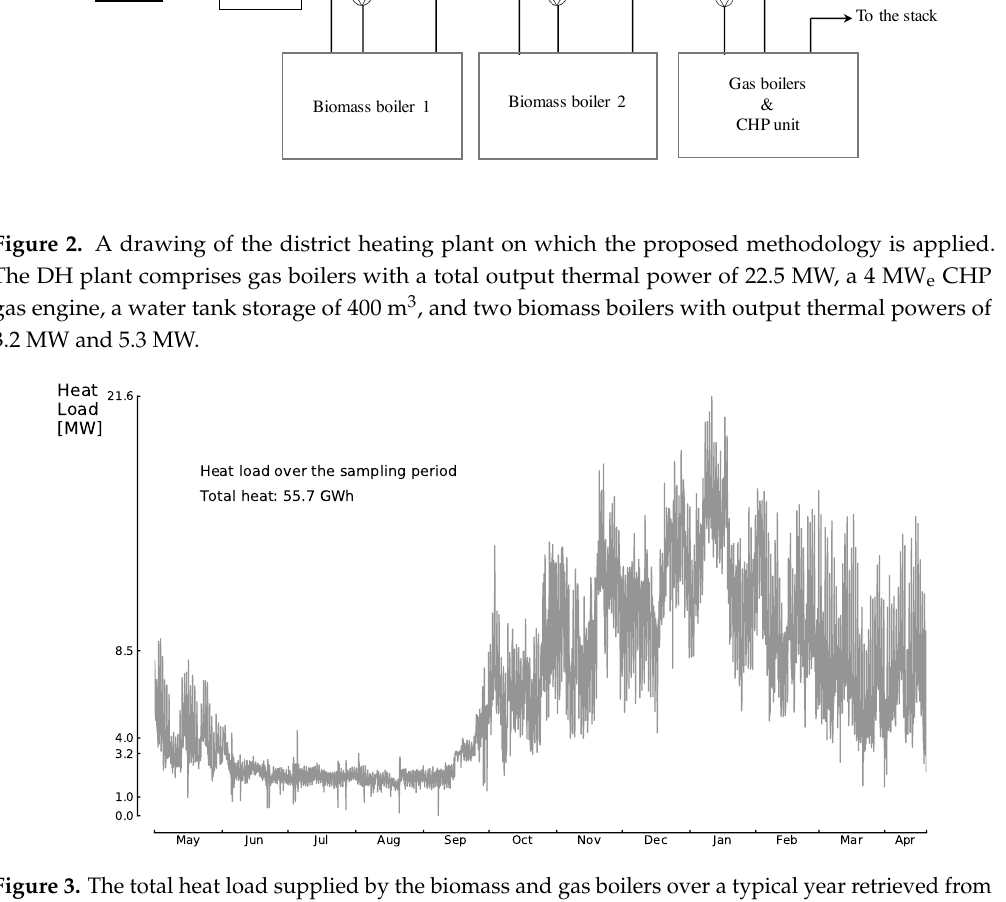
Figure 3. The total heat load supplied by the biomass and gas boilers over a typical year retrieved from an existing DH plant. The DH plant provides 55.7 GWh of heat among which 56% was ensured by biomass boilers, 21% was ensured by the gas boilers, and 23% was ensured by the CHP